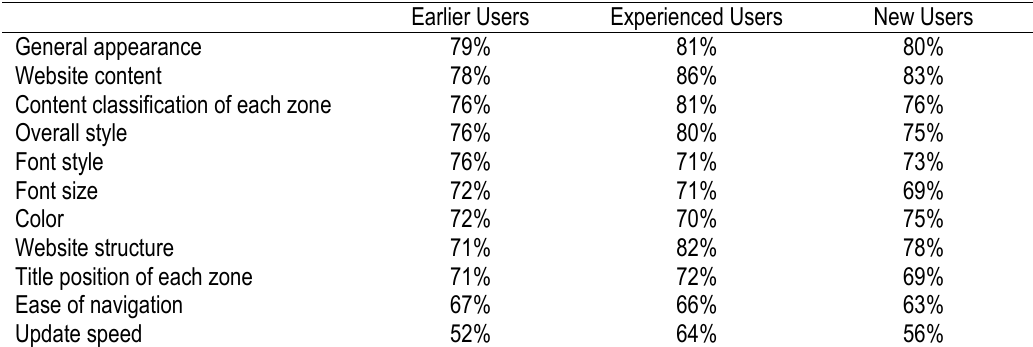
Table 2. Users’ Satisfaction of the